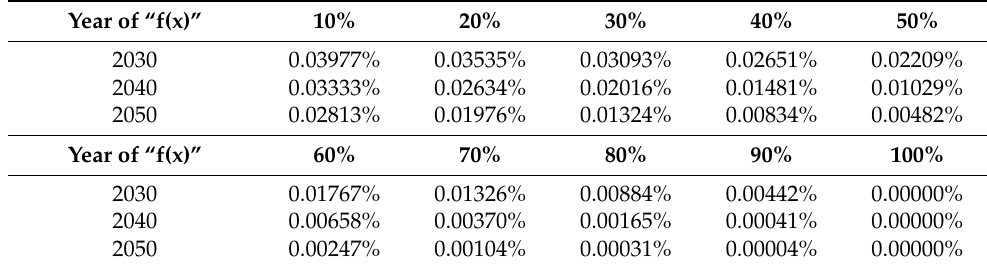
Figure 1. Cryomation penetration simulation. Table 1. Cryomation penetration simulation for the years 2030, 2040, and 2050.